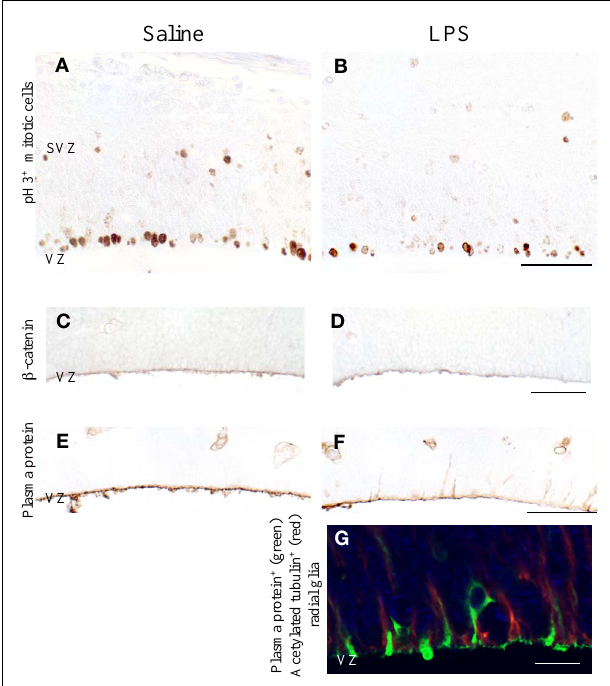
FIGURE 5 | Effect of maternal inflammation on the ventricular zone at E13. Maternal inflammation at E13 has profound effects on cortical development.There is a decrease in proliferation in the ventricular zone (A,B) . As well as this, there is a disruption of the ventricular surface, indicated by decreased β -catenin immunoreactivity (C,D) and uptake of proteins from the CSF (E,F) , by acetylated tubulin positive radial glia (G) . Scale bars = 50 μ m for (A–F) , 10 μ m for (G) . Modified from Stolp et al.